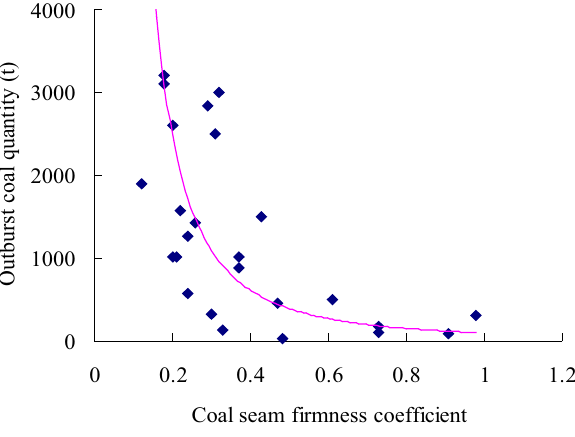
Figure 3. Relationship between the outburst coal quantity and coal seam